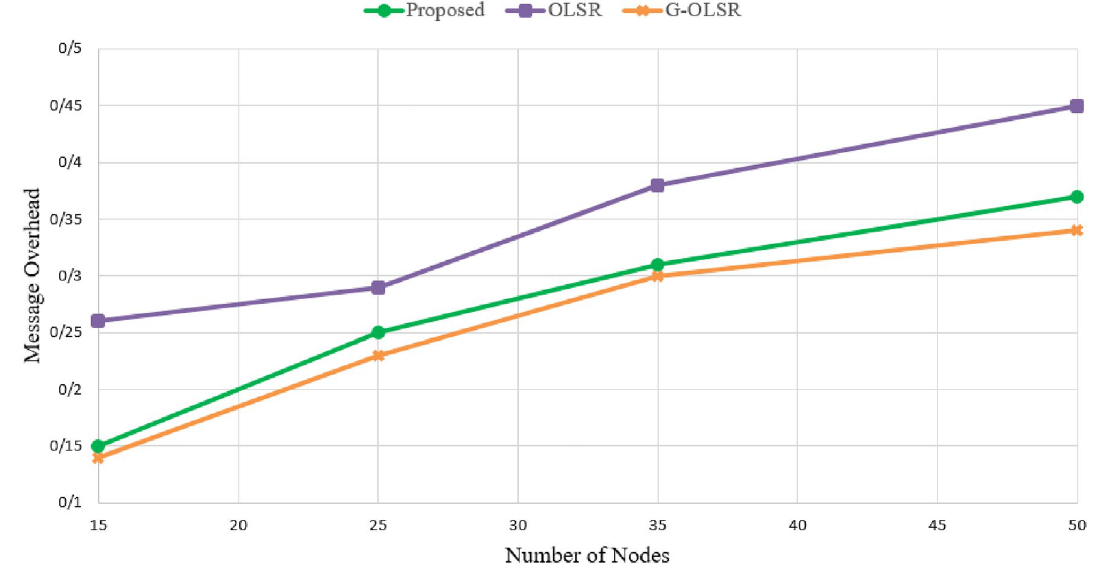
Figure 9. Comparison of different routing methods in terms of routing